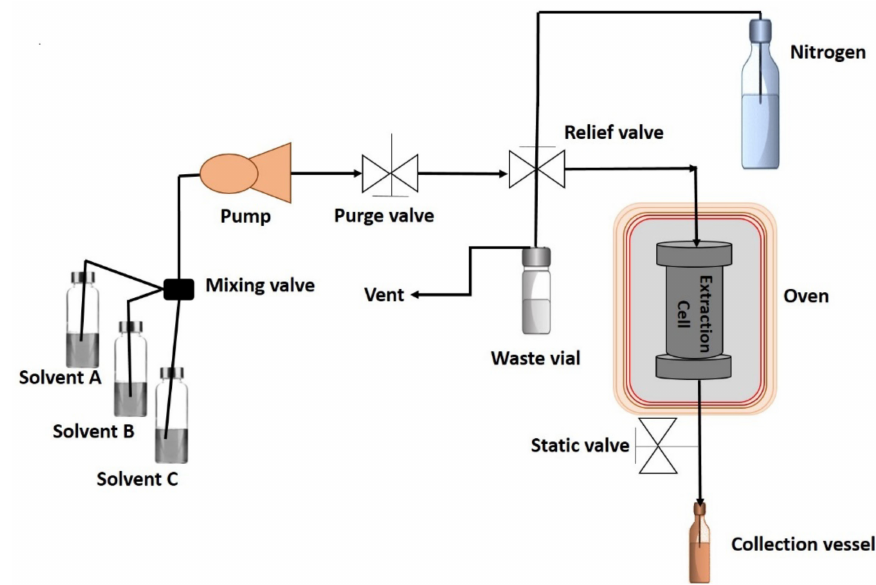
Figure 1. Diagram of pressurized liquid extractor.